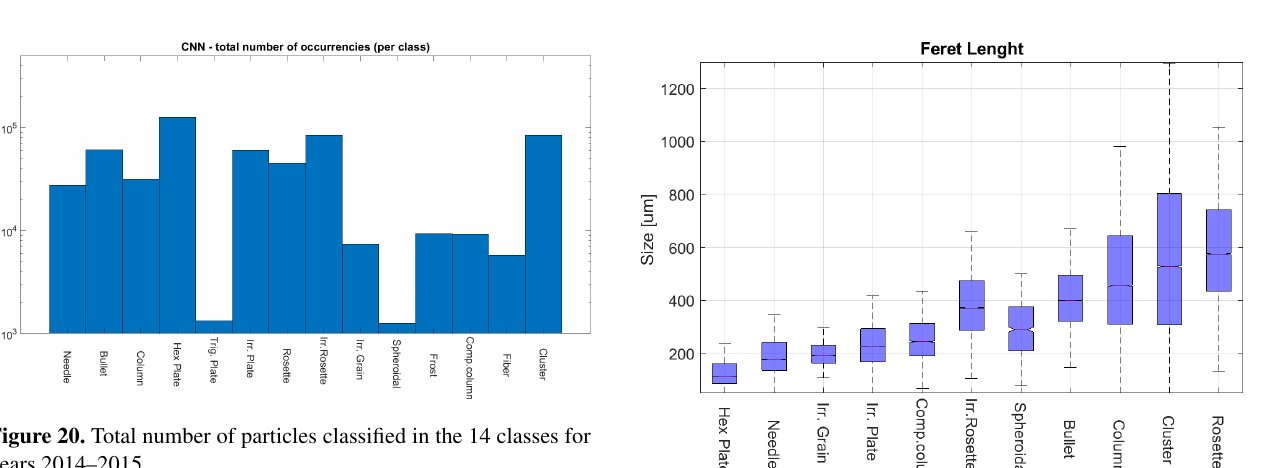
Figure 19. N pS statistics in relation to (a) T air , (b) RH, (c) wind speed. For comparison, the statistics for (d) T air , (e) RHy, and (f) wind speed are shown for the same period (2014–2021).